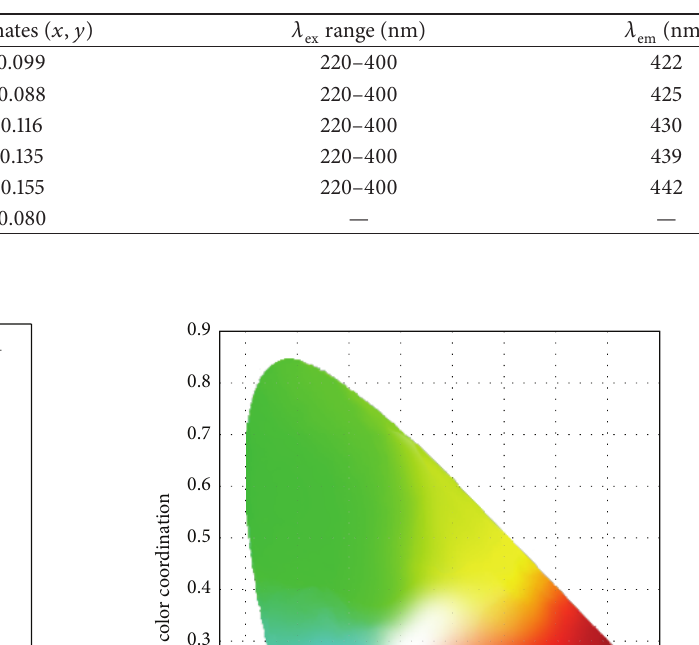
Table 2: Corresponding variations of CIE chromaticity coordinate for Sr 3 B 2 SiO 8 : 𝑥 Ce 3+ ( 𝑥 = 0.0025 ∼ 0.05) phosphor.